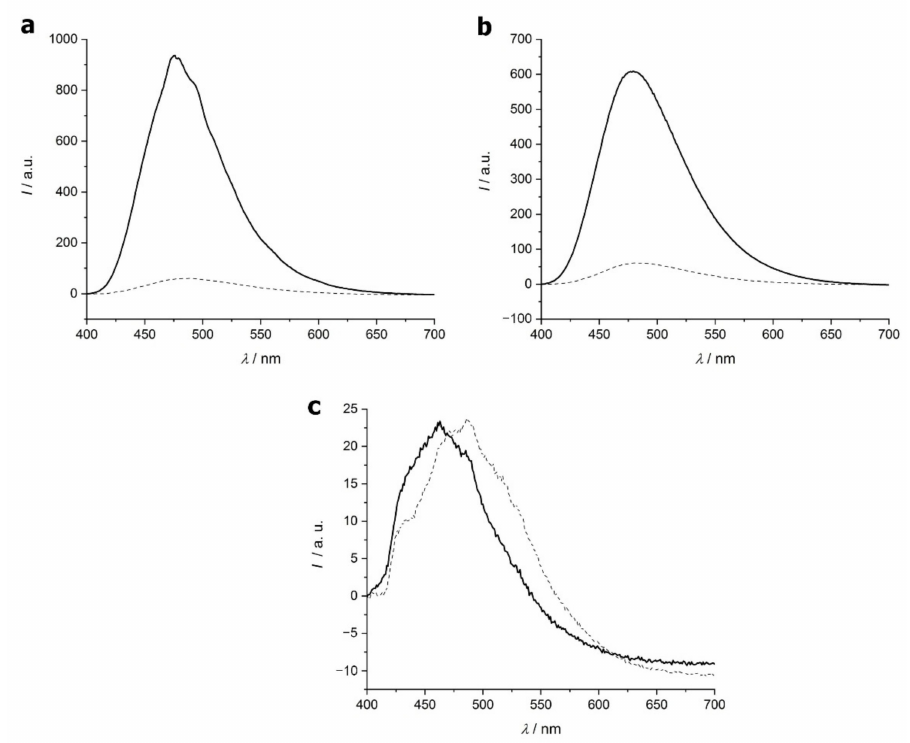
Figure 5. Fluorescence intensity of 8-Anilino-1-naphthalenesulfonic acid (ANS) in the presence of lysozyme ( a ), β -lactoglobulin ( b ) and E5 ( c ). Native proteins are indicated with dashed line and amyloid forms with a solid line. The concentration of ANS was 5 mM, lysozyme and β -lactoglobulin were 1.0 g/L and E5 was 0.59